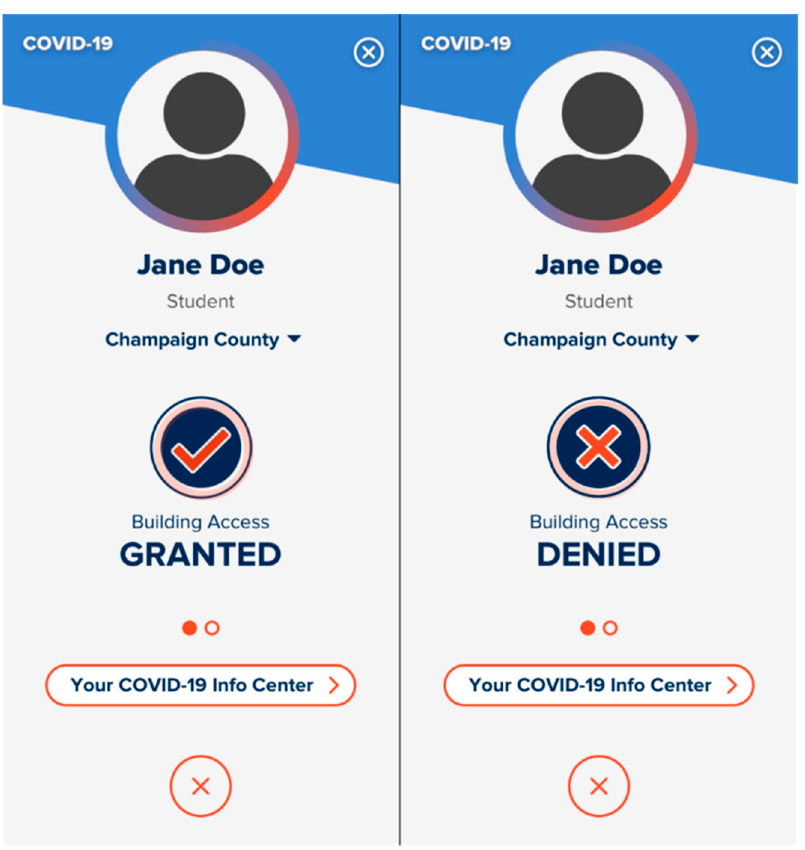
Figure 5. An example of M8 that has been utilized by a university institution in the U.S.: University of Illinois “Safer Illinois App” (source: [42]).